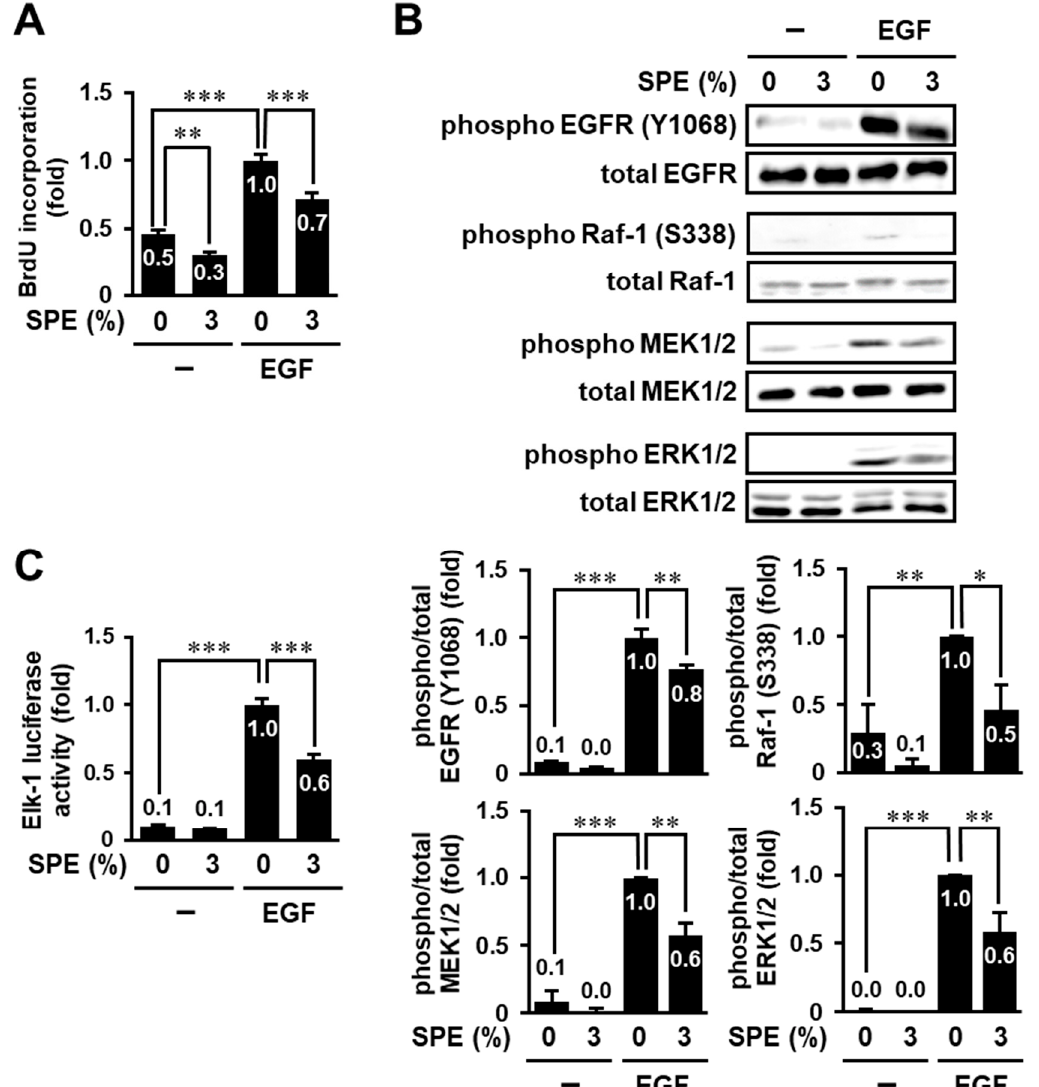
Figure 2. SPE inhibits epidermal growth factor (EGF)-induced cell proliferation and the EGF receptor (EGFR)–extracellular regulated kinase (ERK) pathway in HaCaT cells. ( A ) Serum-starved HaCaT cells were pretreated with 3% SPE for 1 h and subsequently incubated in the presence or absence of 1 nM EGF. After 24 h, the cells were subjected to the BrdU incorporation assay. ( B ) HaCaT cells were serum- starved for 2 h and were treated with 3% SPE for 1 h. Then, the cells were stimulated with 1 nM EGF for 1 h. The cell lysates were analyzed by immunoblot analysis. The levels of phosphorylated proteins